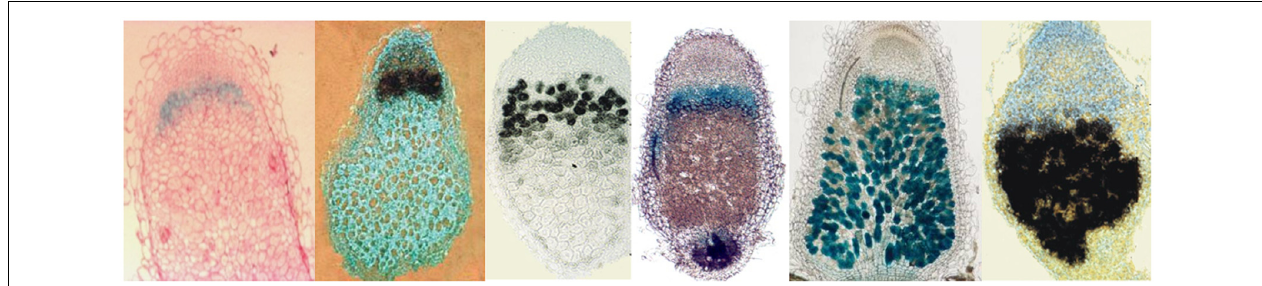
FIGURE 2 | Differential expression of symPEP genes in M. truncatula nodules. Black signal: in situ hybridization, blue signal: GUS activity of symPEP promoter-GUS fusions in transgenic